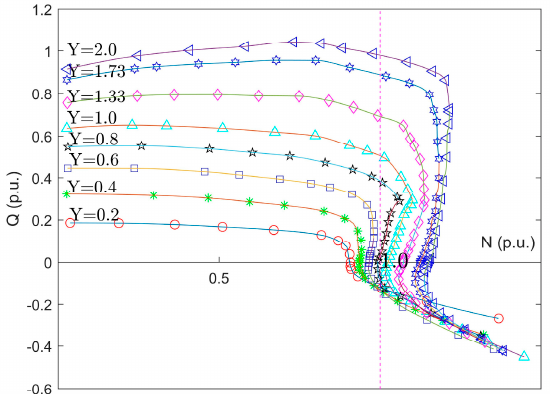
Figure 2. N–Q standard characteristic curve of pump–turbine.